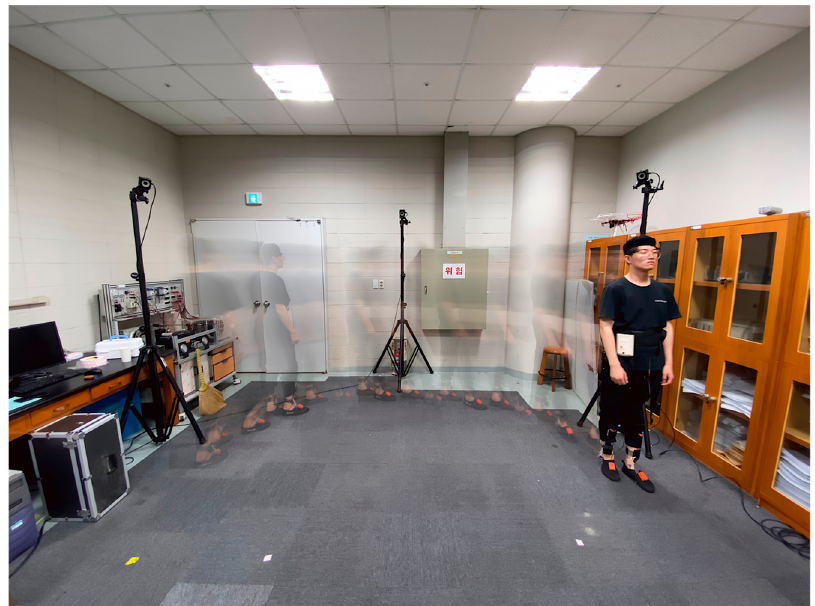
Figure 4. Experiment environment for data acquisition of phase detection in a motion capture area.